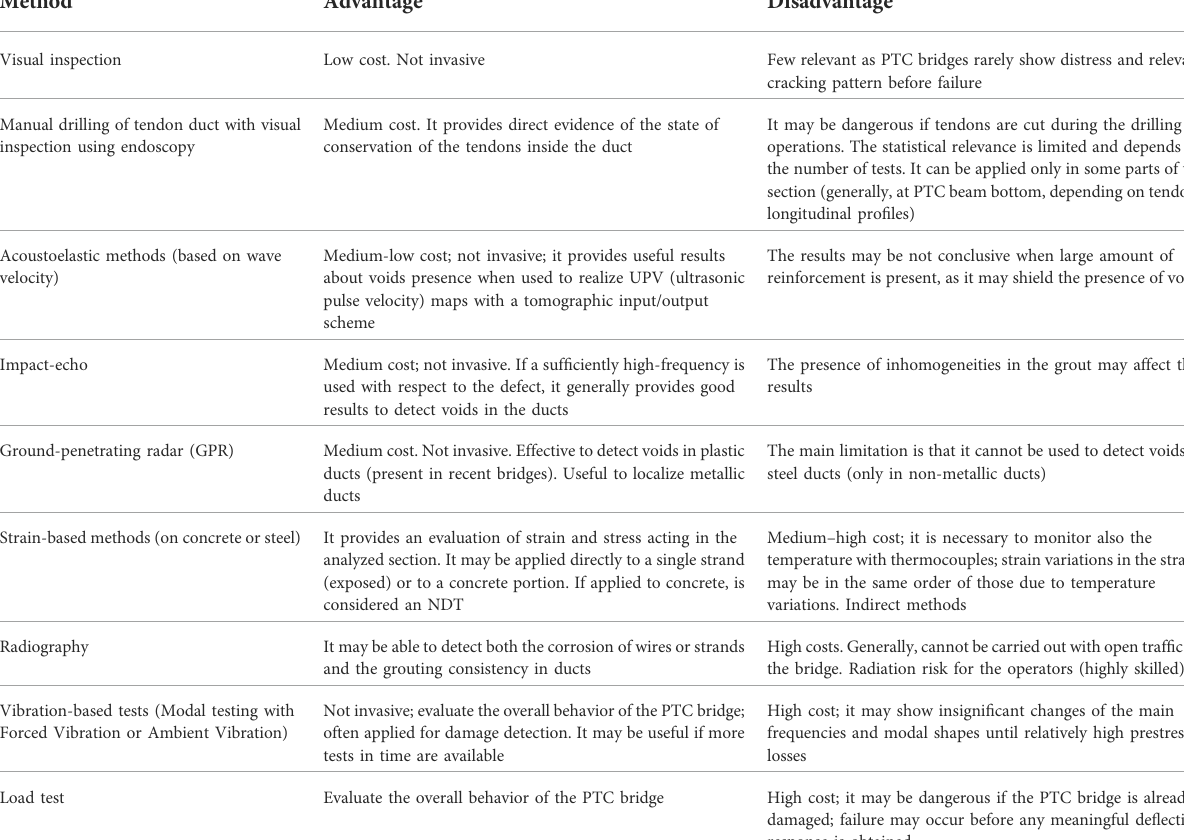
TABLE 1 Current experimental methods applied to PTC bridges for investigating prestress